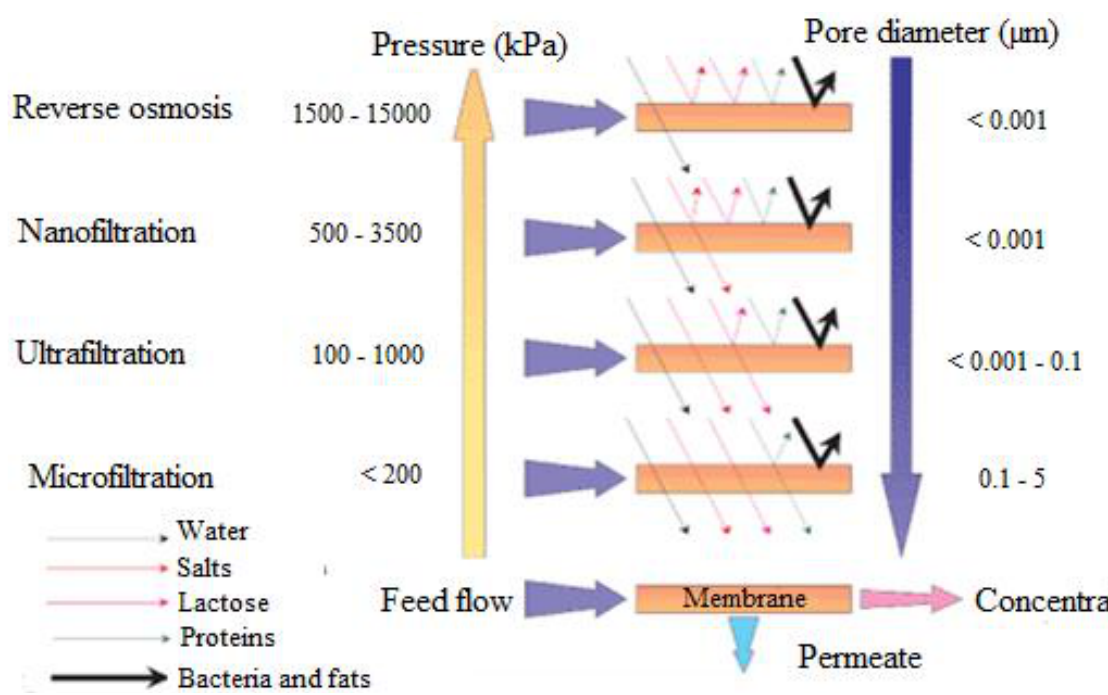
Figure 1. Separation membrane characteristics [18,19].